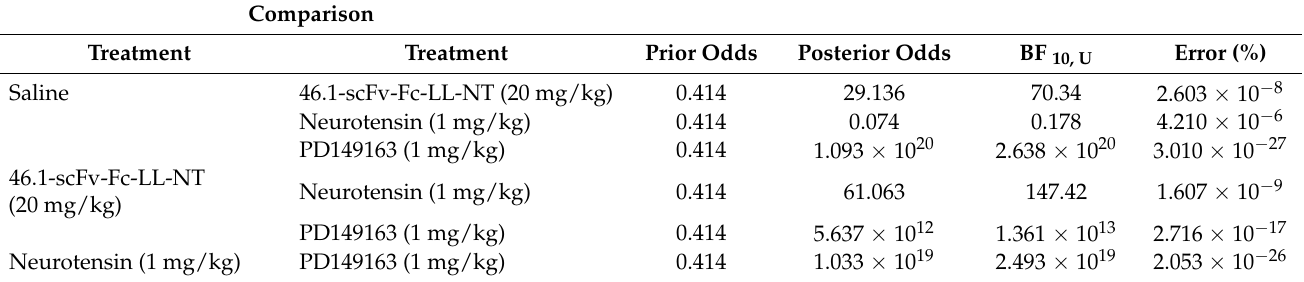
Table 2. The statistical parameters for the Bayesian mixed ANOVA analysis of PCP-induced hyperlocomotion.